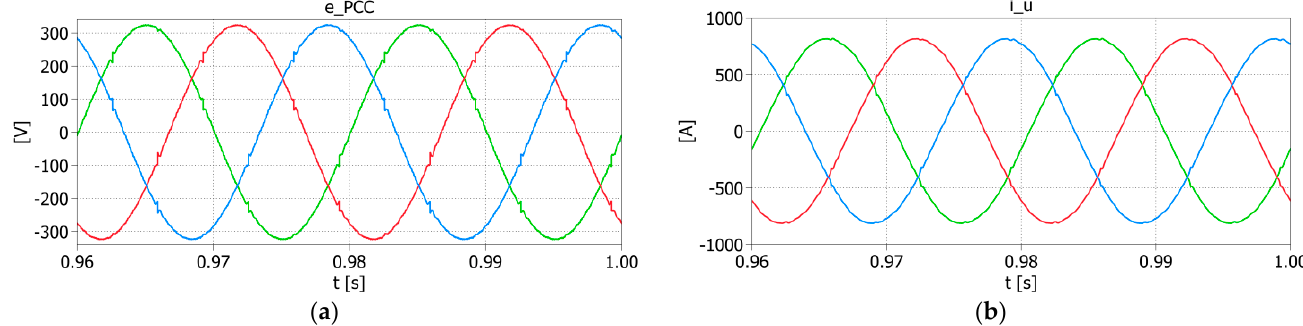
Figure 4. Harmonic compensation disabled: ( a ) voltage waveform in the PCC; THD u = 5.11%; ( b ) upstream current waveform in the PCC; THD i = 23.42%.